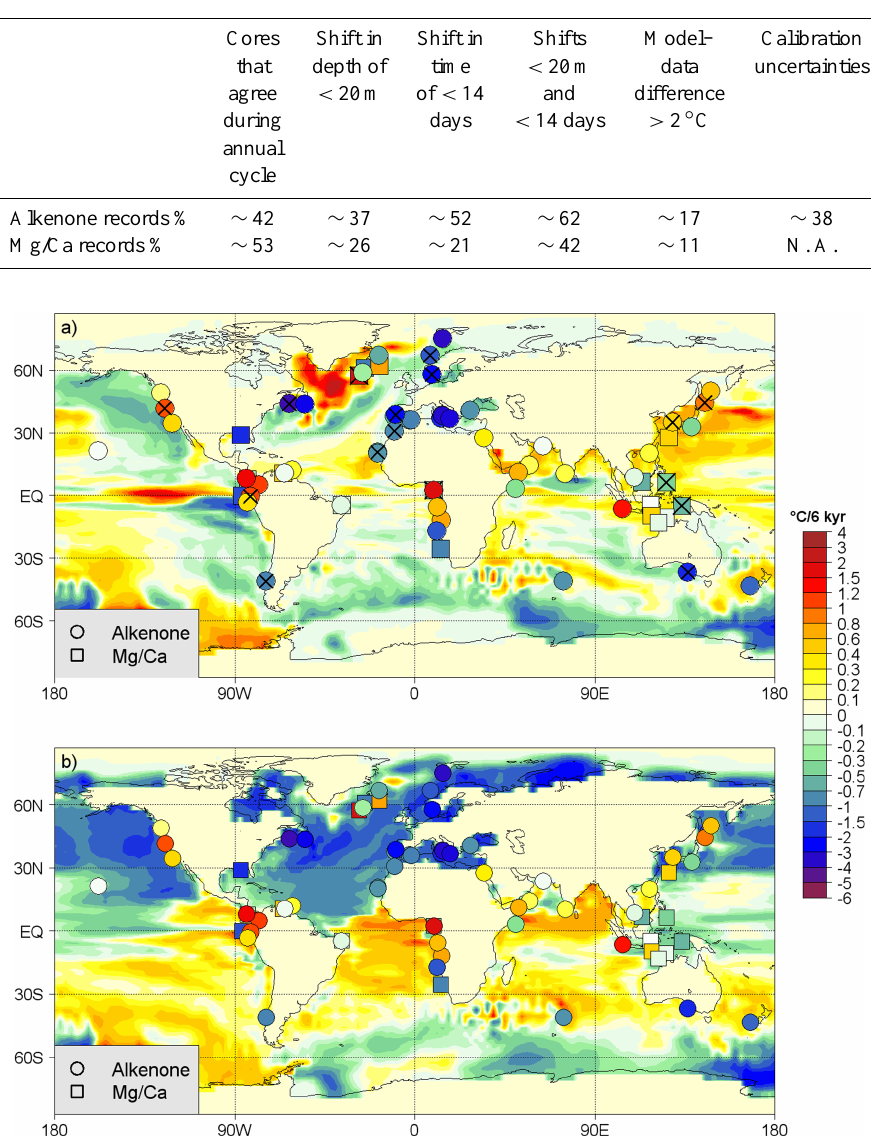
Fig. 10. Local temperature trends based on proxy reconstructions and seasonal SST trends taken from the ECHO-G climate simulation for (a) local winter and (b) local summer. The circles and squares represent the locations of alkenone and Mg/Ca records, respectively; the fill-colour of the data marker represents the recorded temperature trend. Crosses in (a) indicate the record locations where the test of the regression residuals fails to show